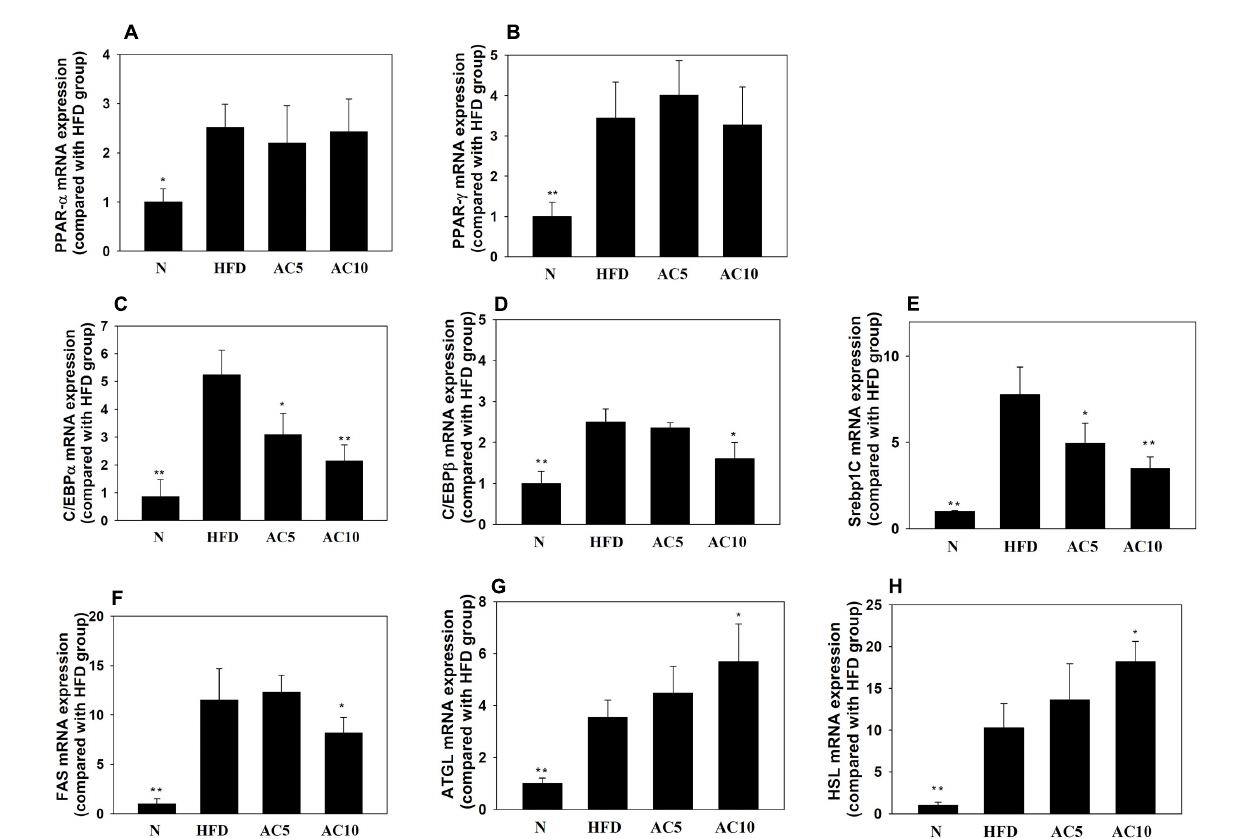
FIGURE 8 | The effect of acacetin (AC) (5 or 10 mg/kg) on gene expression in the visceral adipocyte tissue of mice. Real-time PCR analysis was used to determine the gene expression of (A) PPAR α , (B) PPAR γ , (C) CEBP/ α , (D) C/EBP β , (E) SREBP-1c, (F) FAS, (G) ATGL, and (H) HSL in murine visceral adipocyte tissue. Data are presented as means ± SD, n = 8. ∗ P < 0.05, ∗∗ P < 0.01 compared with HFD-induced obese